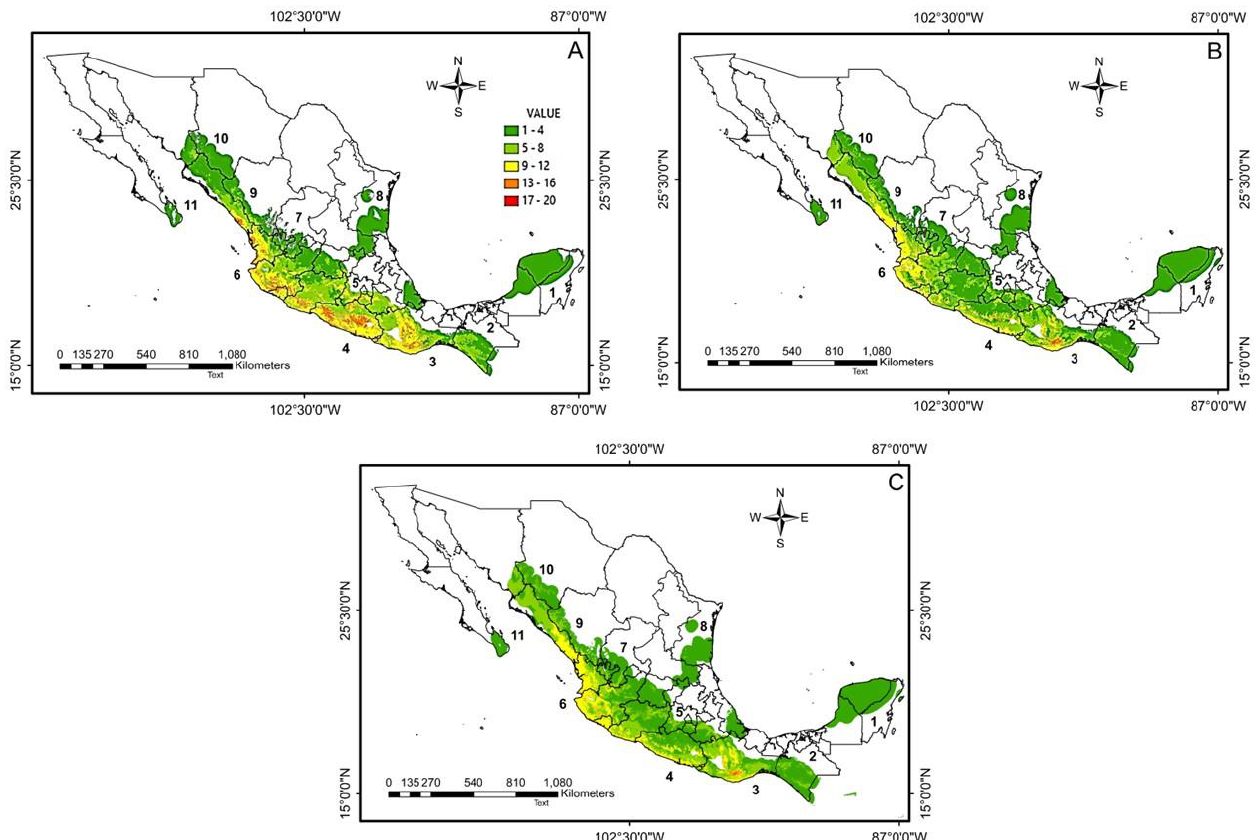
Figure 3. Species richness predicted for 62 anurans endemic to the Mexican tropical dry forest is shown for: ( A ) present, ( B ) RCP 4.5 in 2070, and ( C ) RCP 8.5 in 2070.